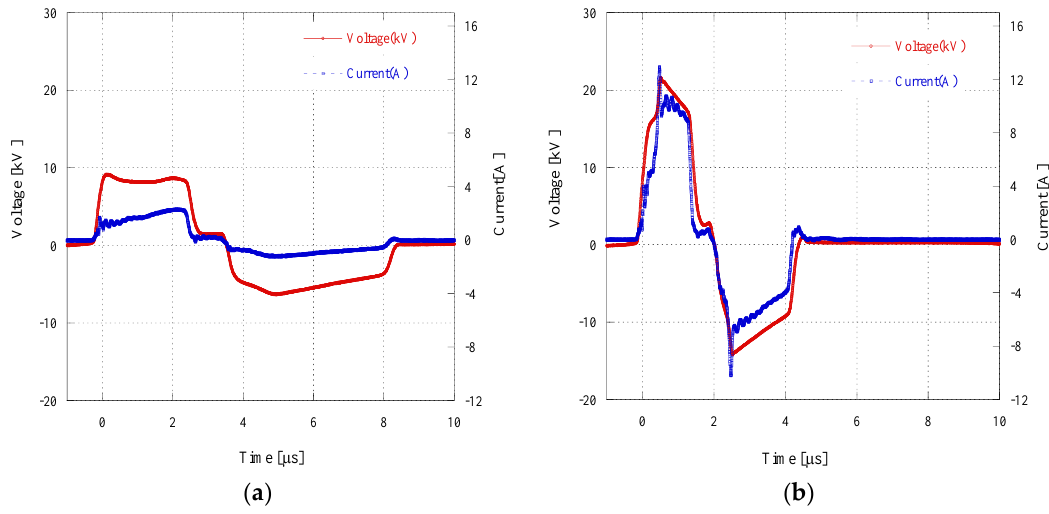
Figure 5. Typical waveforms of voltage and current measured at ( a ) 9.1 kV and ( b ) 21.6 kV during discharge at water surface.